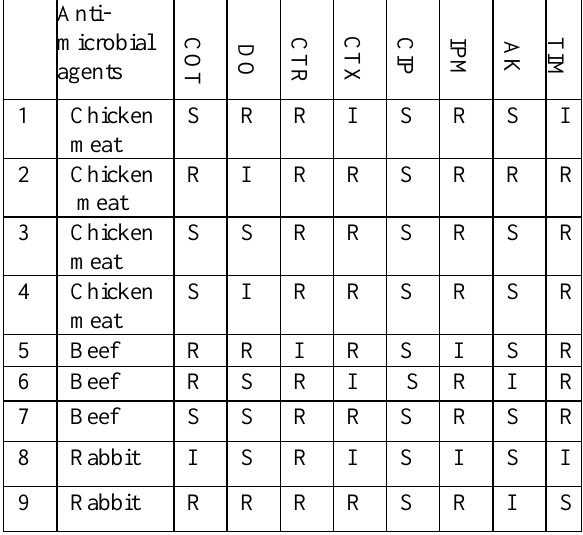
Fig. 4: Antibiotic sensitivity testing result Table 5: Antibiotic sensitivity testing of each Acinetobacter species isolates Anti-